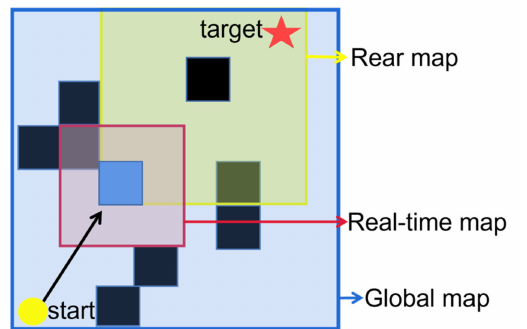
Figure 3. How the map is selected during